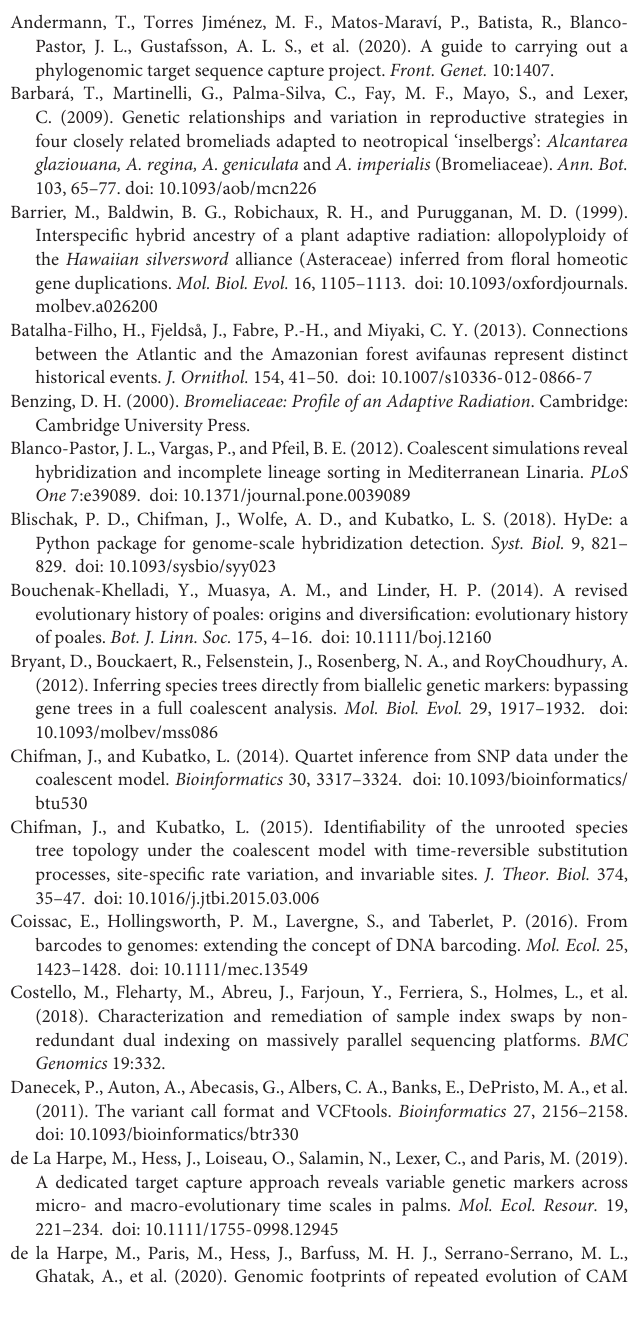
Supplementary Figure 1 | Phylogenetic tree of core Tillandsioideae inferred with RaxML using the concatenated mitochondrial SNPs.